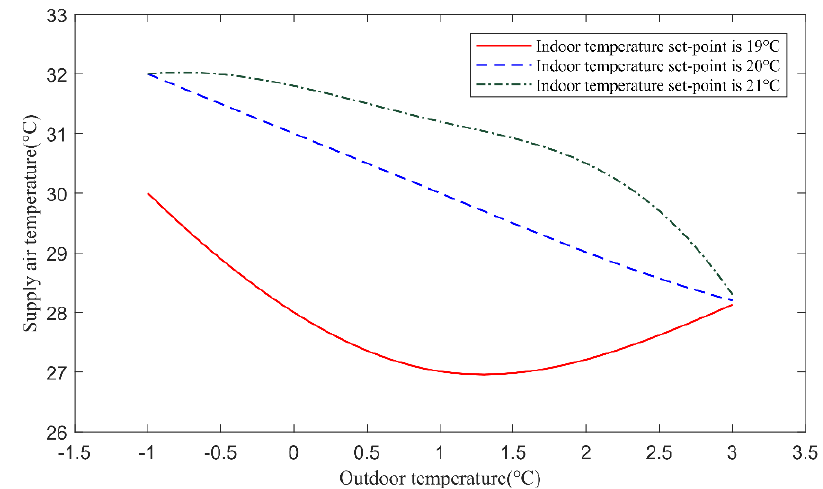
Figure 15. Relationship between outdoor temperature and supply air temperature in winter condition.